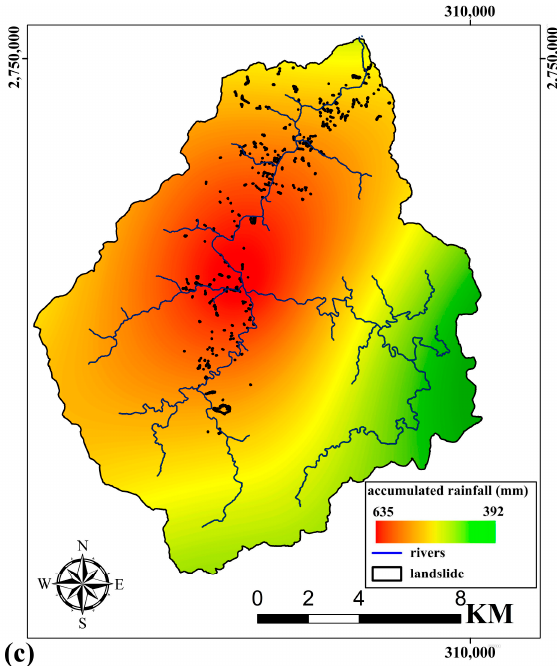
Figure 2. The distribution of accumulated rainfall during typhoon events and landslide in the LRW ( a ), NoRW ( b ), and NsRW ( c ).